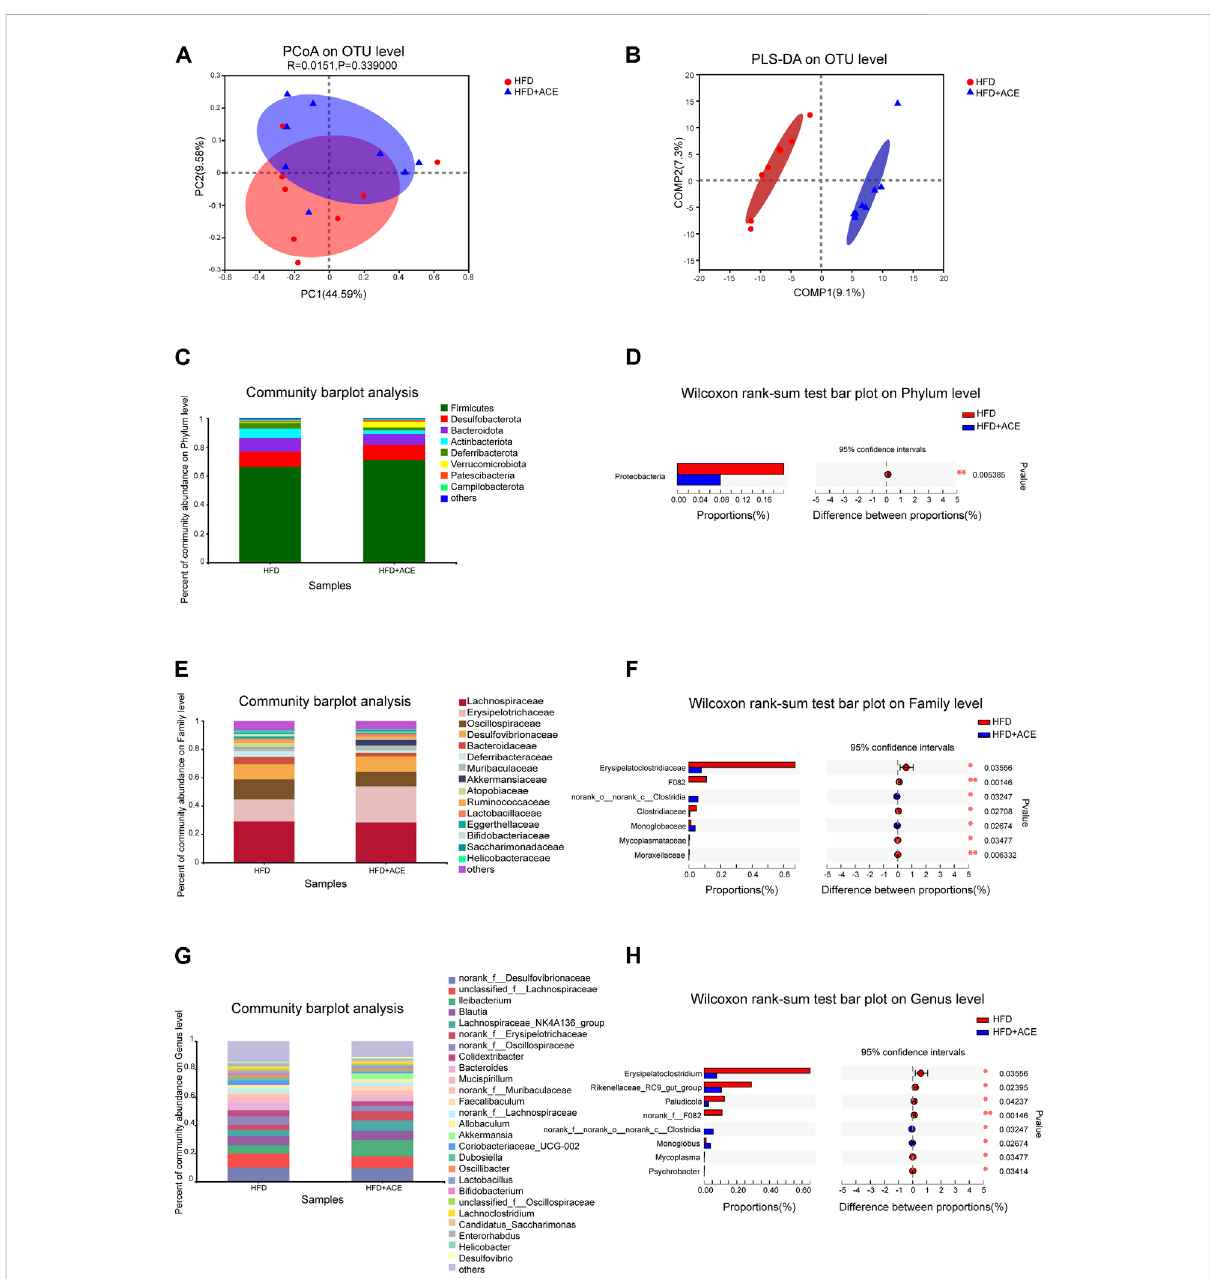
FIGURE 7 ACEchangedthecompositionofgutmicrobiotainHFD-fedmice. (A) Principalcoordinateanalysis(PCoA)onOTUlevel. (B) Partialleastsquares discrimination analysis (PLS-DA) on OTU level. (C) Average relative abundance at the phylum level in each group. (D) The statistical analysis of microbiota at the phylum level. (E) Average relative abundance at the family level in each group. (F) The statistical analysis of microbiota at the family level. (G) Average relative abundance at the genus level in each group. (H) The statistical analysis of microbiota at the genus level. Statistical analysis was performed using Wilcoxon rank-sum test (n = 8 per group). * denotes p < 0.05; ** denotes p <